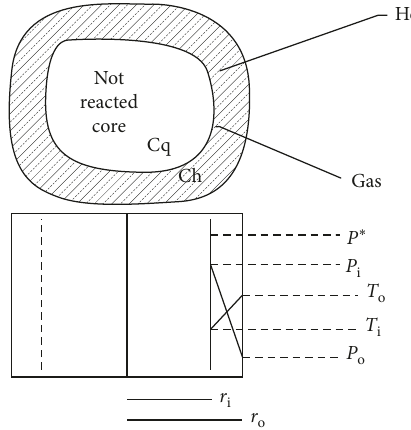
Figure 1: Not Reacted Core model (Cq: palm kernel; Ch: coal; p gas equilibrium pressure; P o : atmospheric pressure; P i : gas pressure at the interface; T o : outside temperature; T i : temperature at the interface; r o : radius of the particle; r i : radius of the interface; r oc : radius of the particle after decreasing